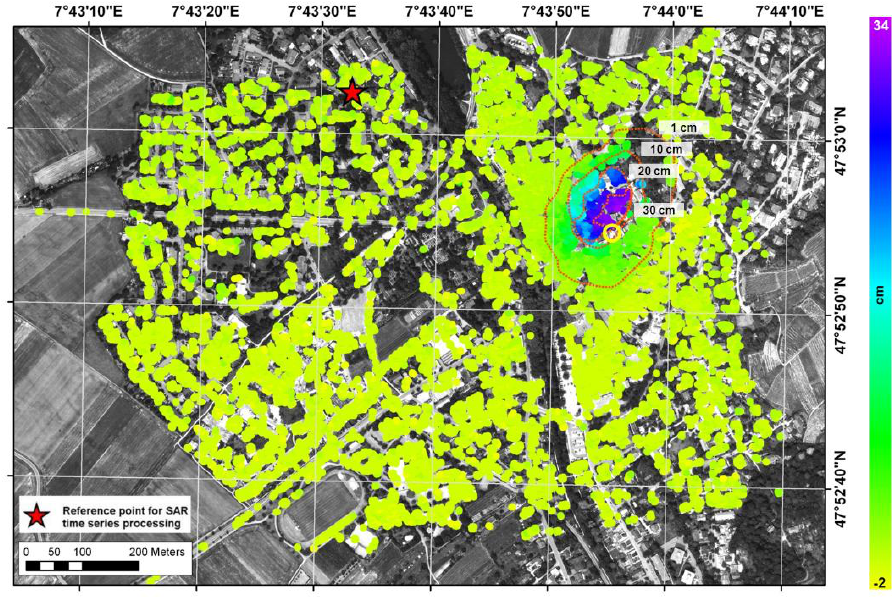
Figure 6. SBAS-derived cumulative line of sight (LOS) displacement in cm from 22 July 2008 through 22 May 2011. The yellow circle indicates the drilling area and the red star represents the reference point for the LOS motion. The displacement boundaries of 1 cm, 10 cm, 20 cm, and 30 cm are highlighted.